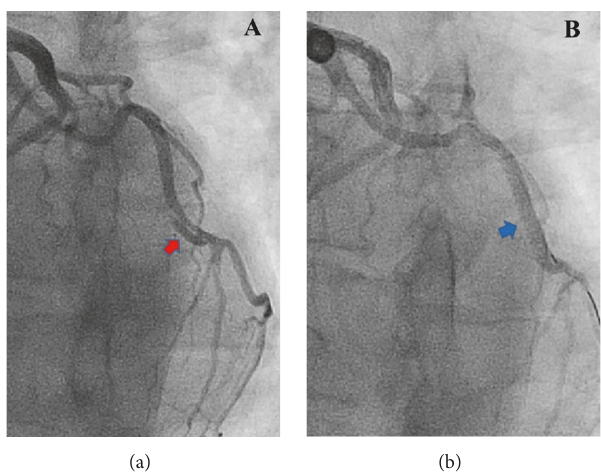
Figure 1: (a) Coronary angiogram shows an intimal flap in the mid left circumflex coronary artery (LCx) confirming coronary artery dissection. (b) Coronary angiogram shows complete revascularization of the LCx after percutaneous coronary intervention. Radiopaque tip of a guide wire was seen in the distal